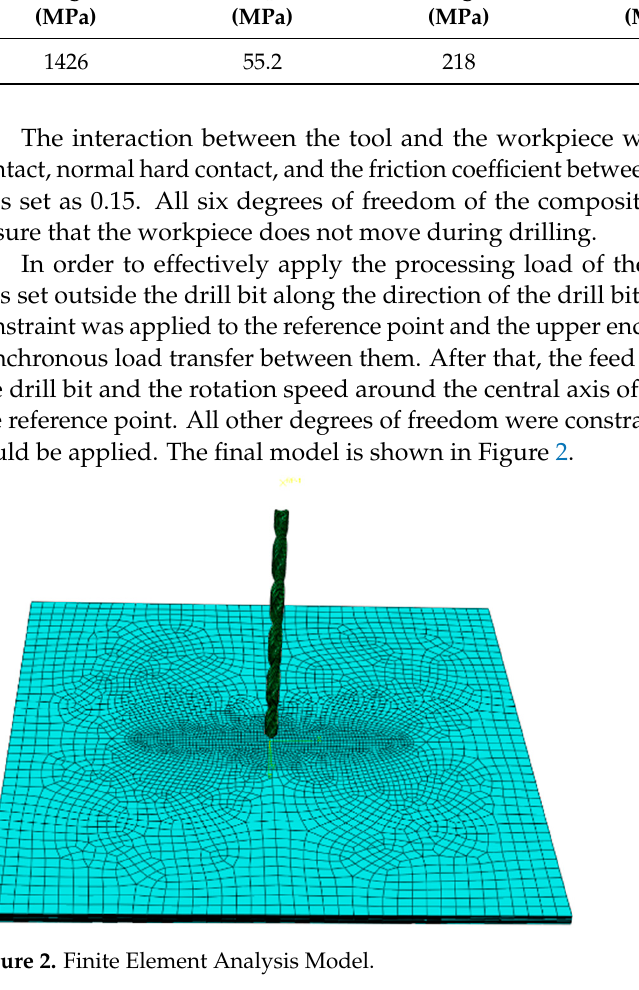
Figure 2. Finite Element Analysis Model.